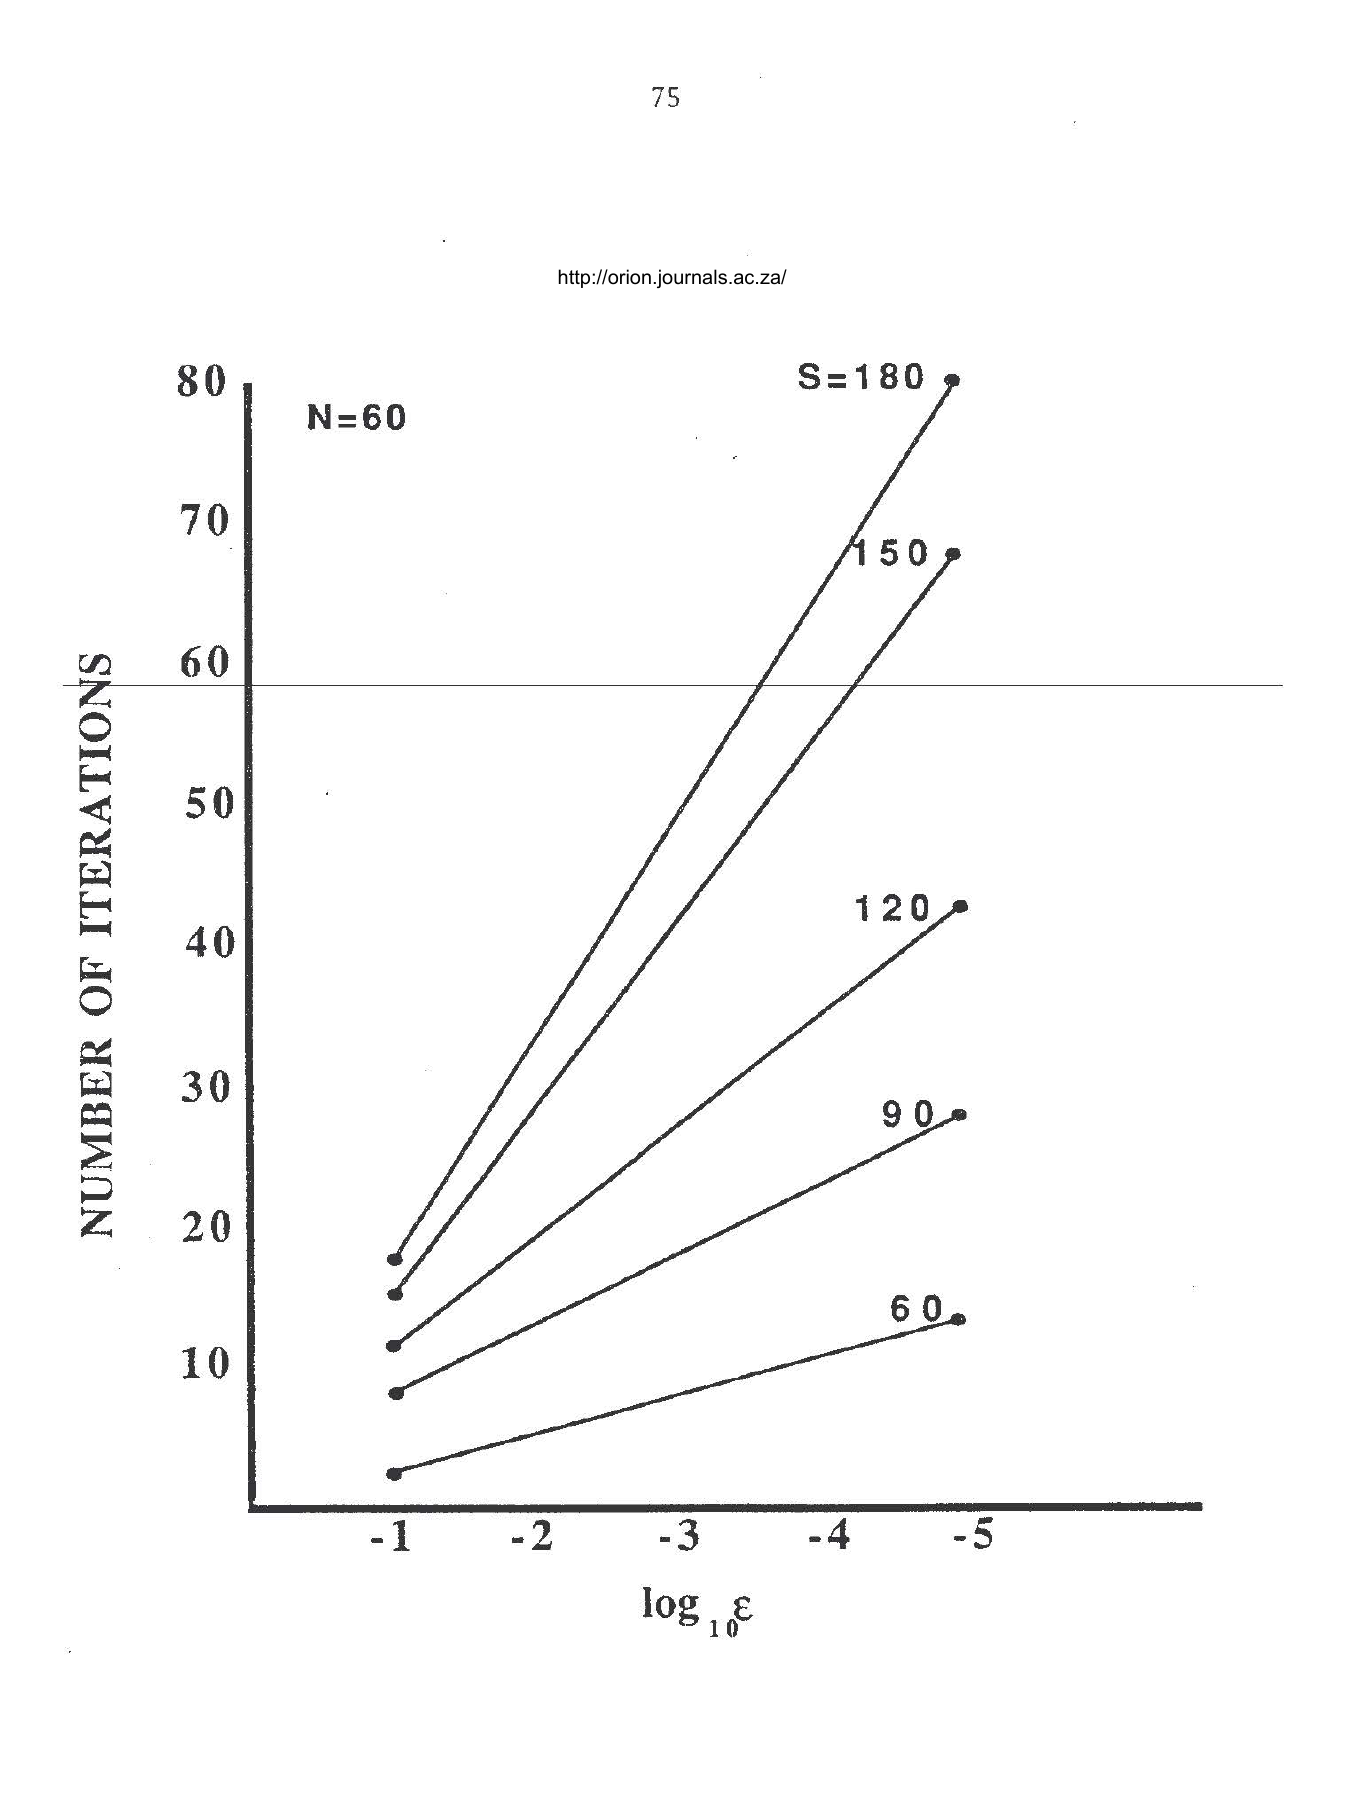
Fig. 2: The dependence of the number of iterations on log E and on S, for = fixed number of constraints (N